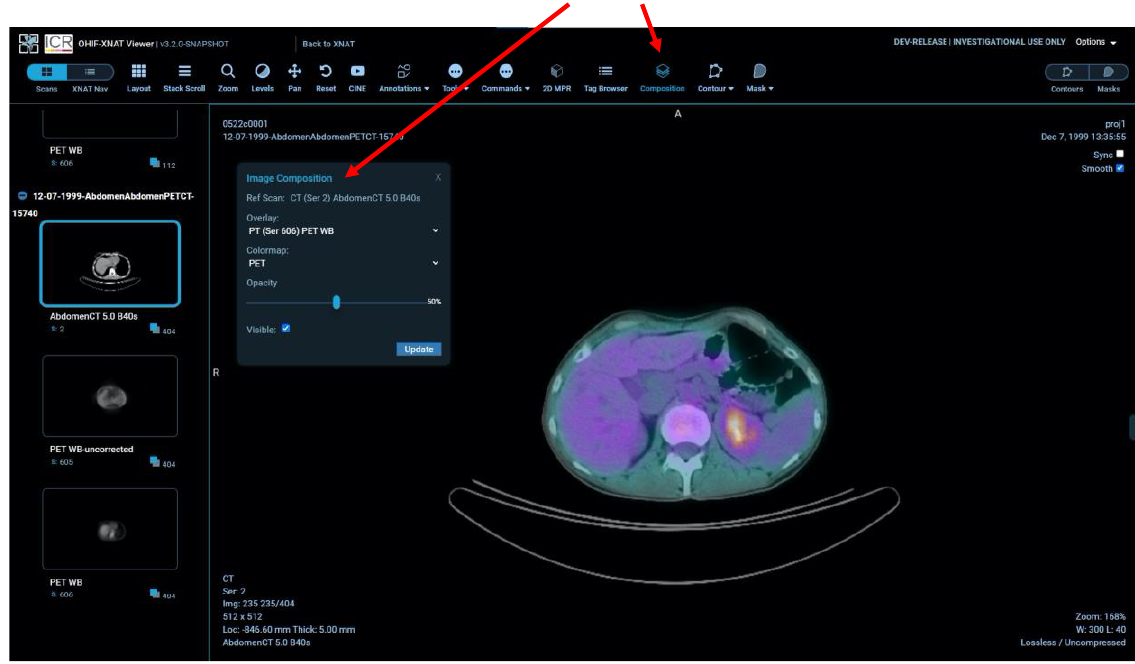
Figure 6. The new image composition tool, allowing overlay of DICOM series within a session to display, for example, PET-CT images.